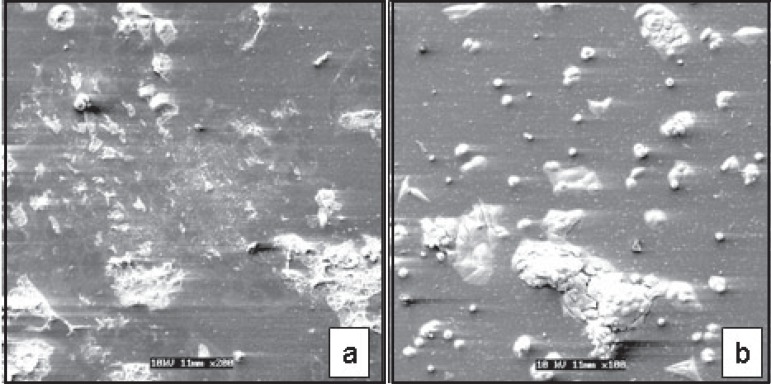
(a): Positive control (3% H2O2) - 2h. Some of the MDPC-23 cells remained
adhered to the glass substrate presented a round shape and total or partial
loss of cytoplasmatic processes [Scanning Electron Microscopy (SEM)
original magnification ×200)]. (b): 2% chlorexidine (CHX) - 2h.
Similar morphology as positive control cells was observed when the cells were
treated with 2% chlorexidine (CHX). (SEM original magnification
×100)